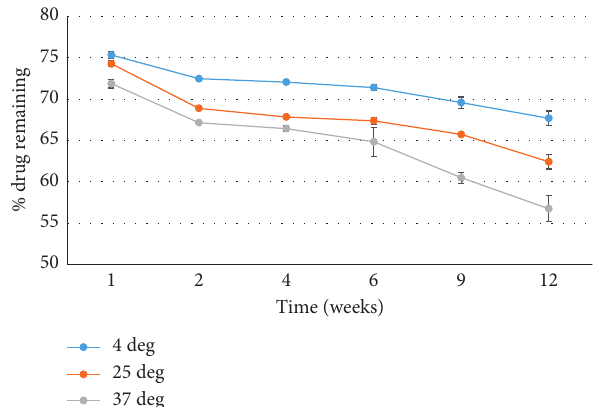
Figure 1: Percentage of levofloxacin remaining within niosomes over eight weeks when stored at 4, 25 and 37 ° C ( p < 0 . 036).